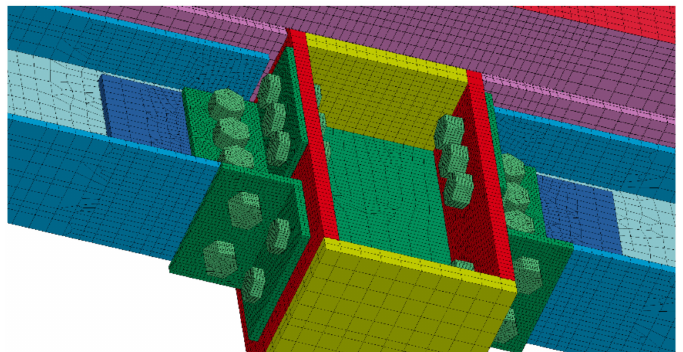
Figure 14. Model M0-RS1: connection region.